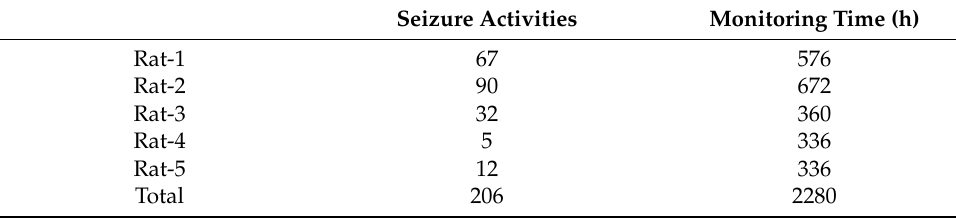
Table 1. Rats and number of seizure